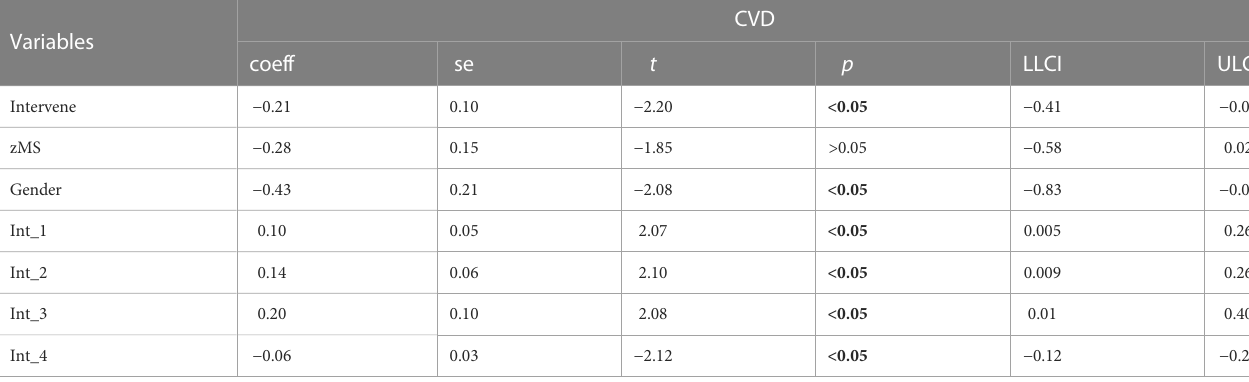
TABLE 18 The moderation analysis between HRBs, zMS, age, and CVD.